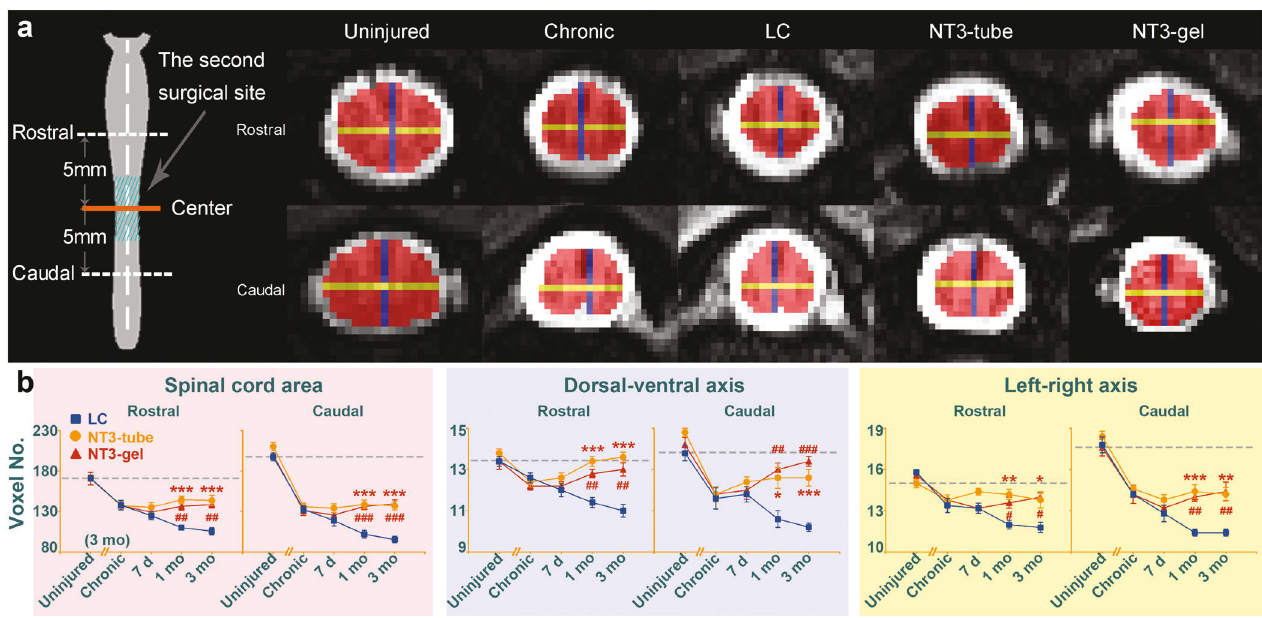
Fig. 5 Comparisons of changes in spinal cord atrophy among three groups after the second surgery. a Diagram shows sampling points, which are 5 mm away from the center of the lesion core. The lengths of spinal cord dorsal-ventral axis and left-right axis as well as the area at the sampling plane were measured for all sample groups and at different time points. These data are plotted in ( b ) to demonstrate dynamic atrophic changes in spinal cord tissues rostral and caudal to the lesion. *, NT3-tube vs. LC; #, NT3-gel vs. LC; *, # P < 0.05; **, ## P < 0.01; ***, ### P < 0.001, by ANOVA. Data are presented as mean ± SEM. Number of animals: n = 5 for each group. See Supplementary Table 2 for exact P